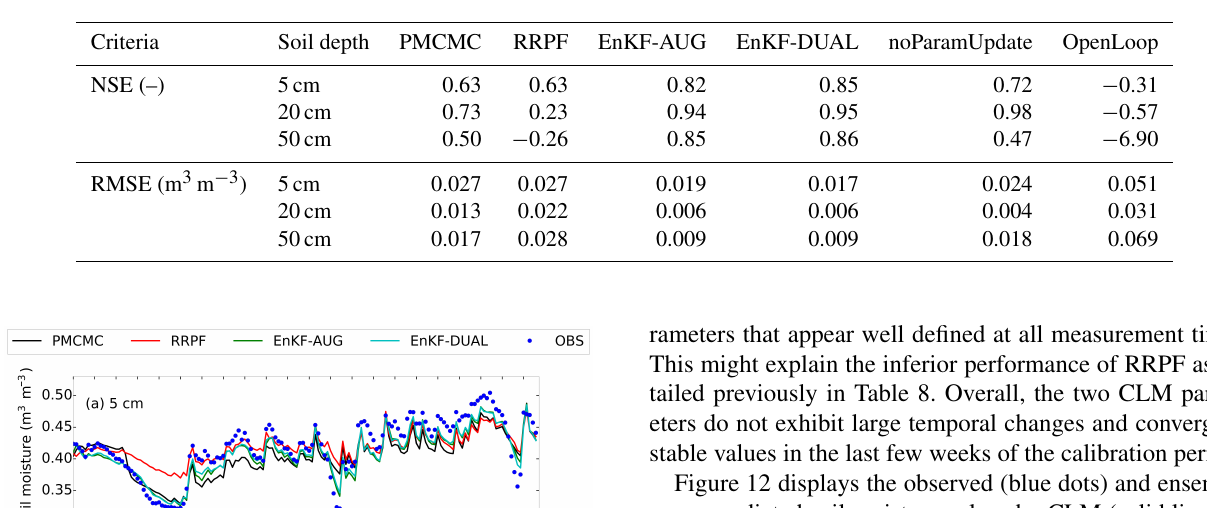
Table 8. Calibration period: values of the NSE and RMSE summary statistics of the quality of fit of CLM for the Rollesbroich soil moisture measurements at 5, 20, and 50cm depths with the PMCMC, RRPF, EnKF-AUG and EnKF-DUAL data assimilation methods. For complete- ness, we also list the performance of the EnKF for state estimation only (noParamUpdate) using CLM parameter values drawn randomly from the prior parameter distribution, and the performance of an open-loop run of CLM (OpenLoop) using the mean simulation of many different CLM parameterizations drawn randomly from the prior parameter distribution.